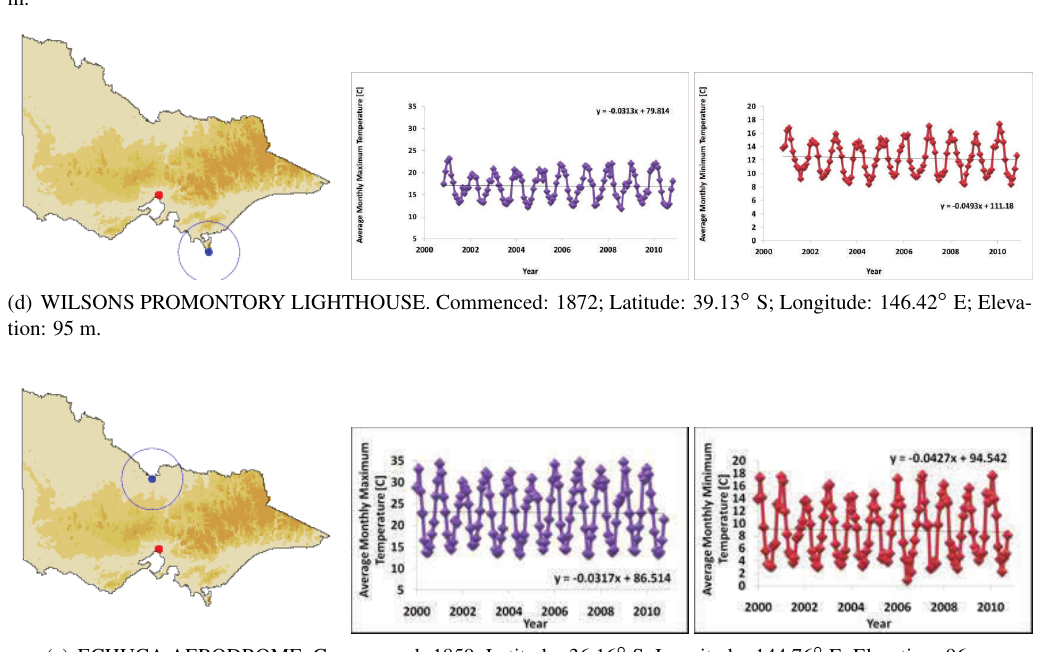
Figure 4. Last decade raw data for monthly mean maximum and minimum temperatures for selected historical measuring stations in Victoria,